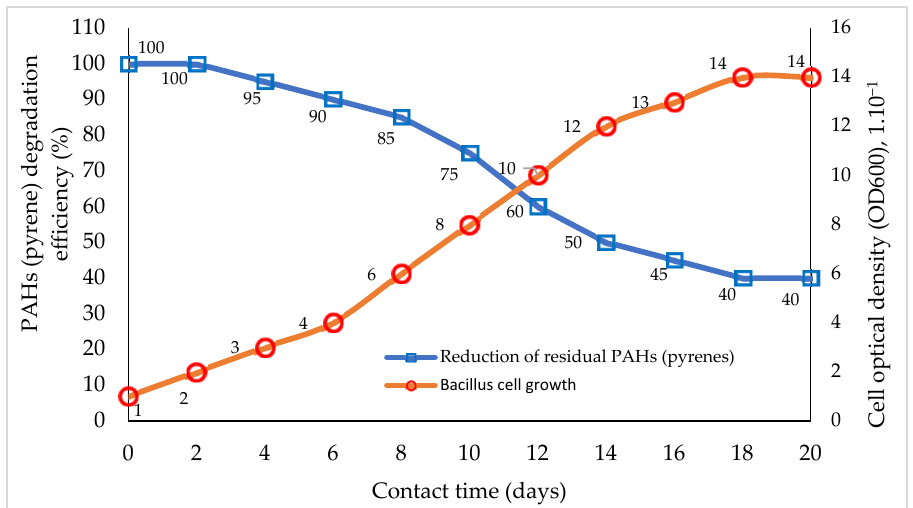
Figure 1. Comparison of the percentage of PAH (pyrene) bioremediation with bacterial cell growth rates based on interaction time. Graphically modified figure [13,16,110,113,116].